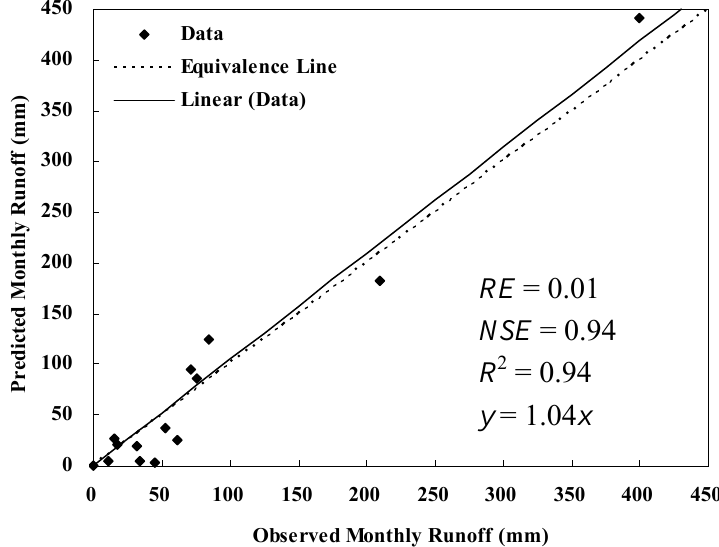
Figure 1. Comparison of observed and predicted monthly runoff at Wuxi hydrological station during calibration year